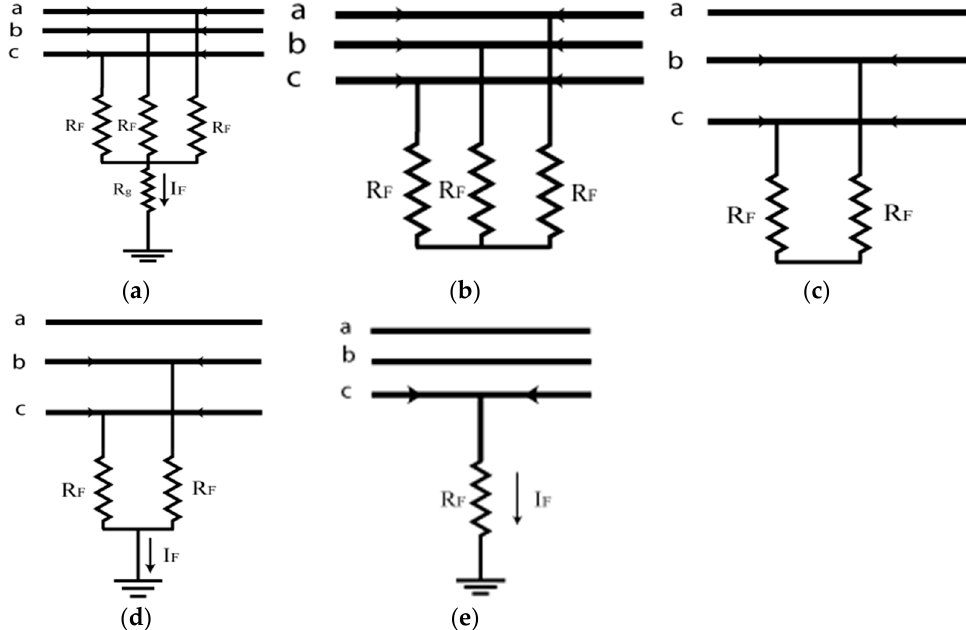
Figure 2. ( a ) Three-phase to ground fault, ( b ) Three-phase fault, ( c ) Double line to ground fault, ( d ) Double line to ground fault, ( e ) single line to ground fault [18].